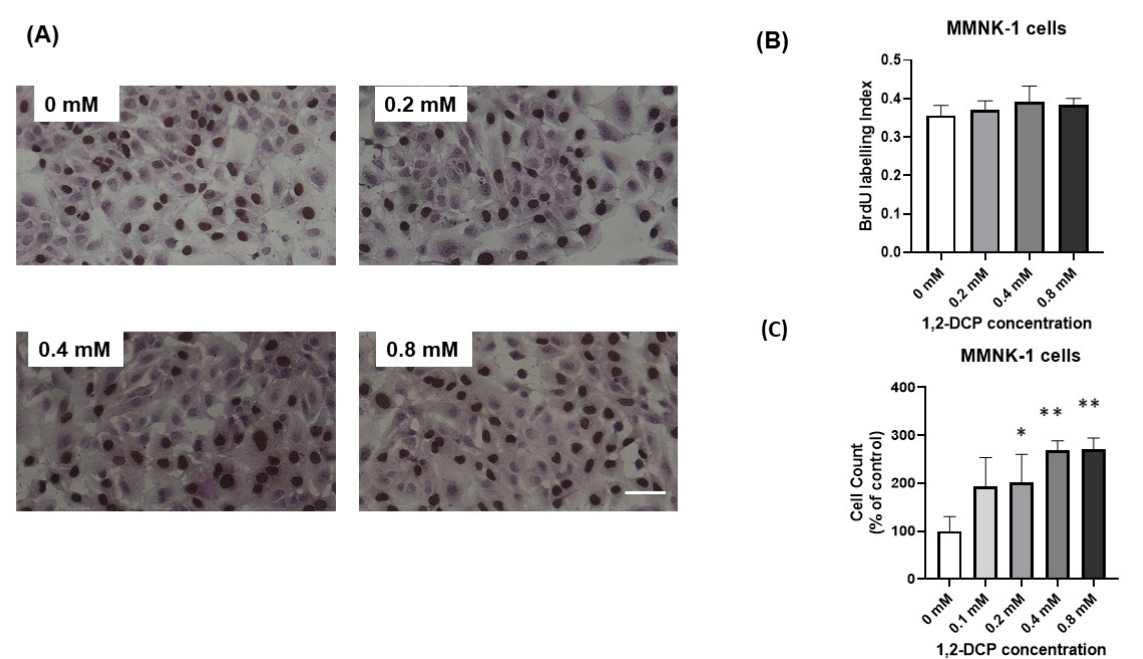
Figure 2. Effects of 1,2-DCP on cell proliferation of monocultured MMNK-1 cholangiocytes. Monocultured MMNK-1 cells were exposed to 1,2-DCP at 0, 0.1, 0.2, 0.4, and 0.8 mM for 24 h. ( A ) Photomicrographs of BrdU immunocytochemistry. MMNK-1 cells were incubated with BrdU labelling medium for 45 min. The cells were washed, fixed with ethanol, blocked with hydrogen peroxide and 1% BSA in PBS, and incubated with anti-BrdU antibody, then with the secondary antibody. The brown color was developed using DAB and nuclei were counterstained with hematoxylin. Cells were observed under a light microscope. Scale bar = 100 µm. ( B ) BrdU labelling index (ratio of the number of BrdU-positive nuclei to the total number of nuclei). ( C ) Cell count (Percentages are in relation to 0 mM 1,2-DCP group). Data are mean ± SD, n = 3. * p < 0.05, ** p < 0.01 compared with the control group (0 mM), by one-way ANOVA followed by Dunnett’s multiple comparison test.